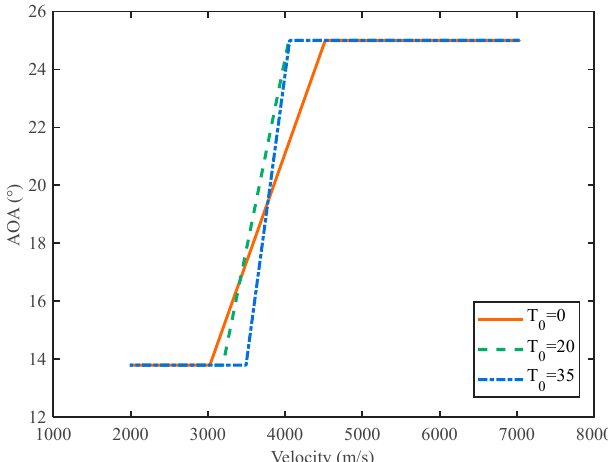
Figure 12. Velocity histories of the AOA.